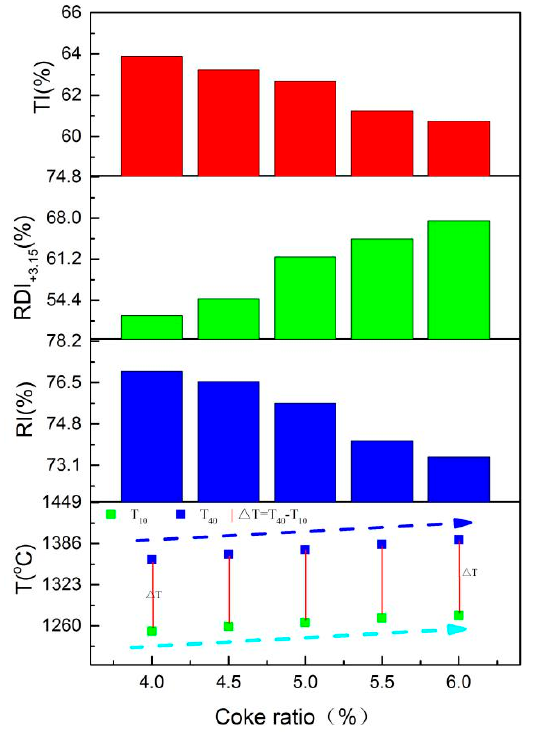
Figure 7. Effect of the coke ratio on the HCVTS metallurgical performance.